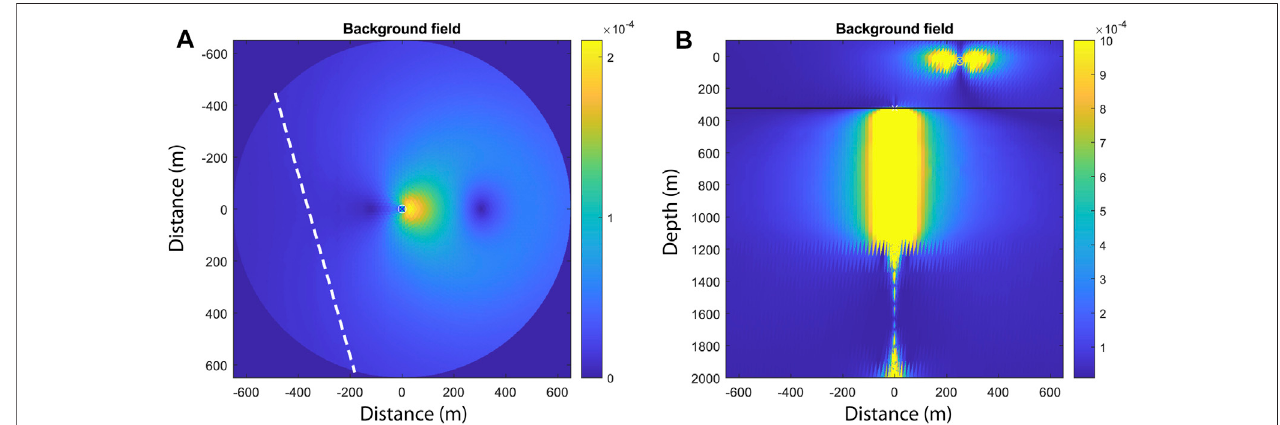
FIGURE6|(A) Amplitudeofthe x horizontalcomponentofthemodeledelectrical fi eld[A/m]atthesea fl oorforthereferencecase(conductivity=4×106 S/m).The plot represents a horizontal cross-section at the sea fl oor, i.e., the horizontal and vertical axis correspond to x - and y -axis, respectively. (B) Amplitude of the x horizontal component of the modeled electrical fi eld [A/m] along the plane corresponding to y = 0 (vertical cross-section). The black line corresponds to the sea fl oor.